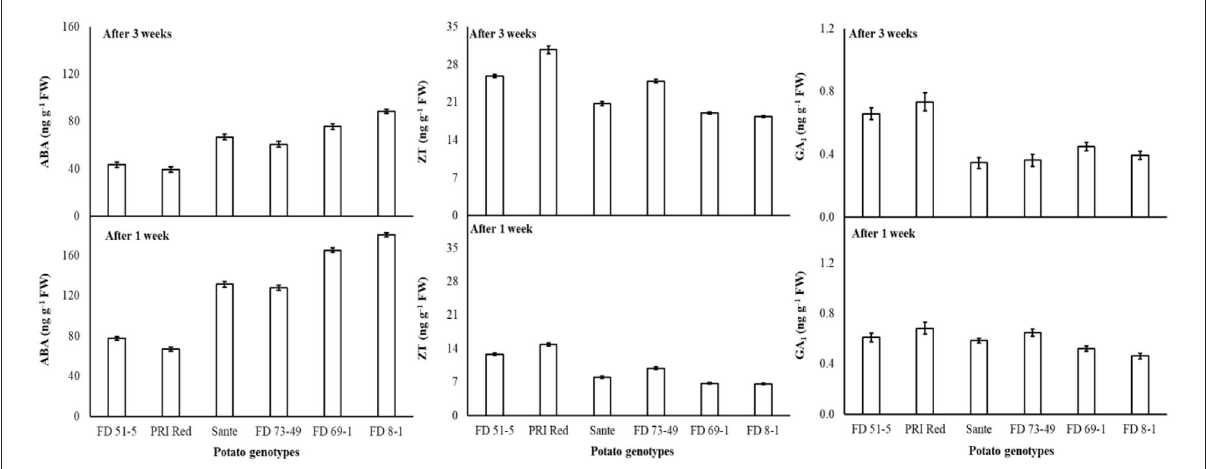
FIGURE4 Change in ABA, ZT, and GA 1 levels in tuber during storage period (3 weeks) following treatment with benzylaminopurine and gibberellic acid together. Vertical error bars represent standard error of means (n: 4).